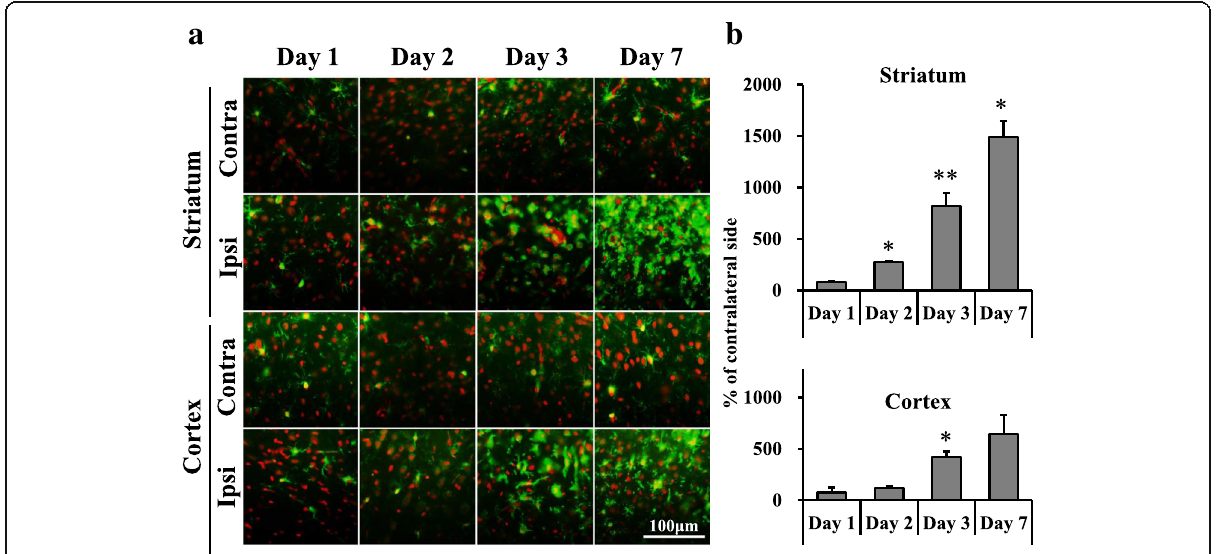
Fig. 5 Immunostaining with Iba1 in the dorsal striatum and cerebral cortex after mild focal ischemia. a Merged immunostaining images are showed with Iba1 (green) and PI (red) at 1, 2, 3, and 7 days after 20-min middle cerebral artery occlusion (MCAO). Scale bar, 100 μ m. Contra, contralateral side; Ipsi, ipsilateral side. b Graphs show % of contralateral side, with values expressed as mean ± SD (day 1: n = 3, day 2: n = 4, day 3: n = 4, day 7: n = 3). Asterisks indicate significant differences compared with the contralateral side, * p < 0.05, ** p <